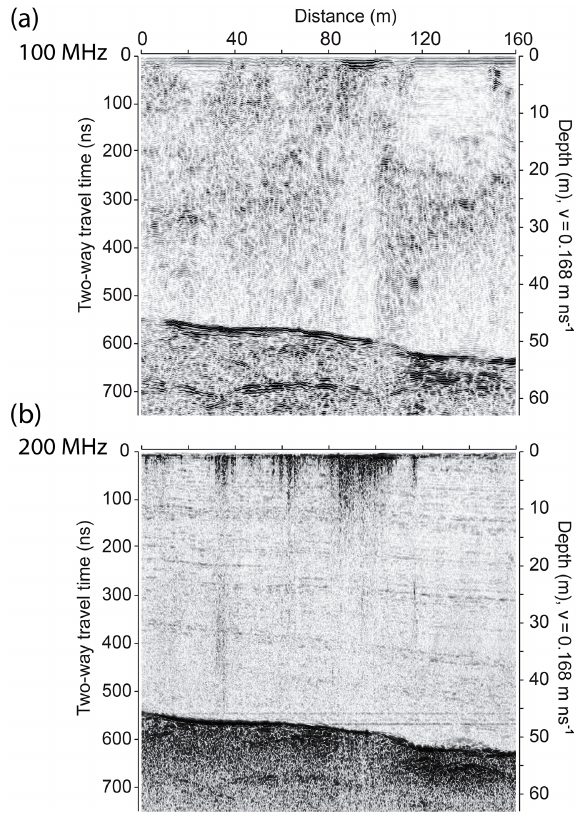
Figure 2. Example of processed radargrams recorded with 100MHz (a) and 200MHz (b) over the same profile (position shown in Fig. 1). Increased near-surface reflectivity at 100MHz co- incides with incoherent noise near surface at 200MHz (especially between 80 and 100m) and is interpreted as meltwater. Note that the horizontal lines in 200MHz around 550 and 570ns are